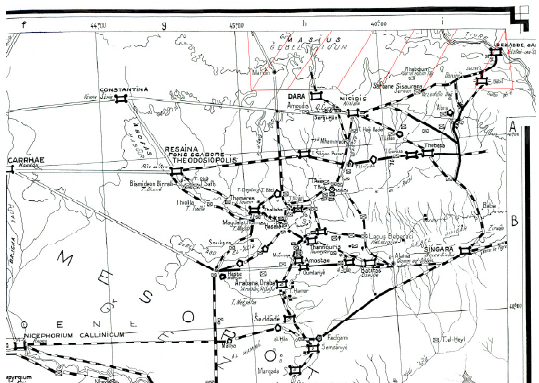
Fig. 1. Poidebard, 1934. Original scale 1:100 000. SE corner of map illustrating the area east of Mardin to the River Tigris. Area of the FSAPM research project is shown in the red rectangular